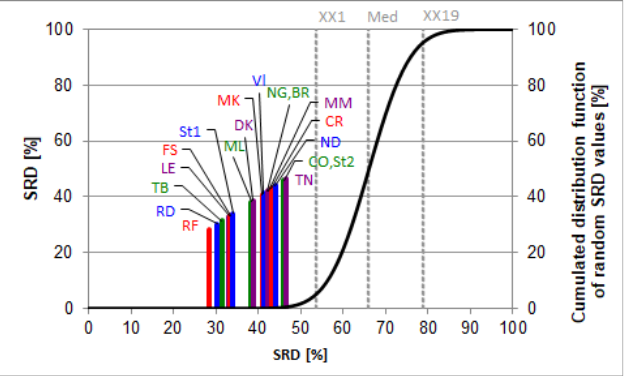
Figure 1. The SRD values (scaled between 0 and 100) of the experts based on their ratings determined by sum of ranking differences. Maximum values were used as the reference (benchmark) column, which had the highest scores. Scaled SRD values are plotted on the x axis and left y axis, right y axis shows the relative frequencies of random ranking distribution function: black curve. The probability ranges are also given as 5% (XX1), Median (Med), and 95% (XX19). Codes of the experts are listed in the data set